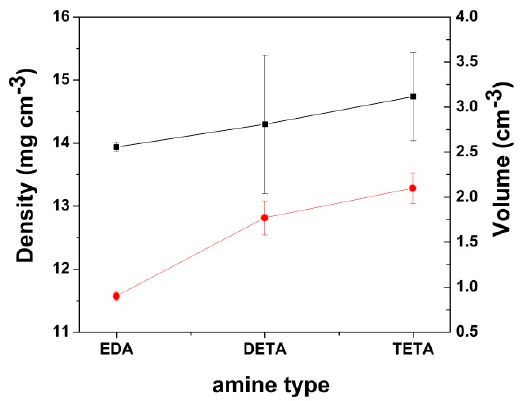
Figure 3. Modified cryogel volume and density with the amine functionalities.